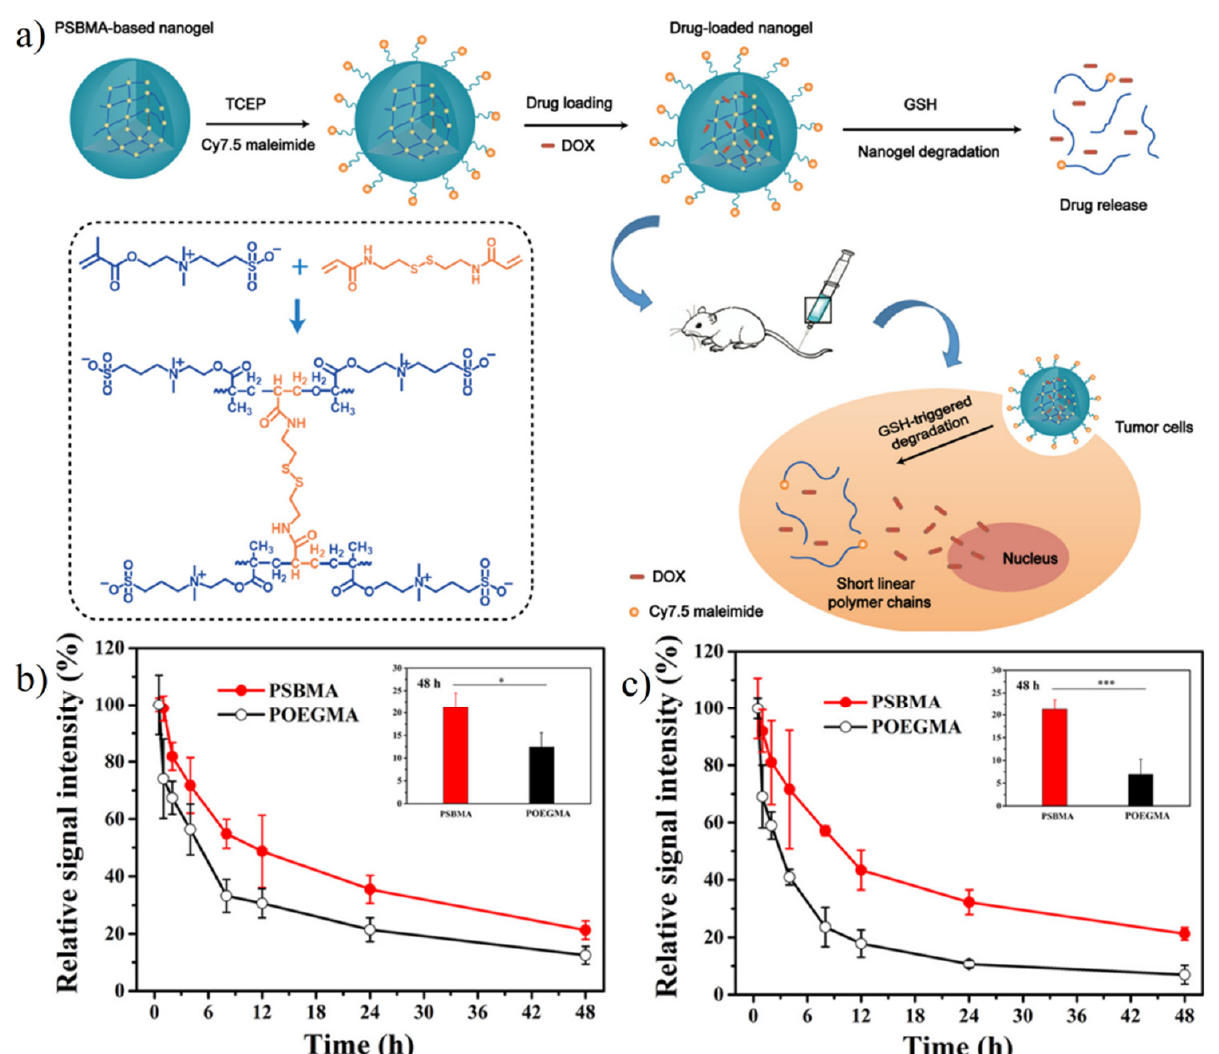
Figure 17. Redox-responsive controlled release of pSBMA-based nanogel. ( a ) Schematic illustration of doxorubicin-loaded biodegradable pSBMA-based nanogel for tumor therapy. ( b ) Blood retention of POEGMA nanogel and PSBMA nanogel after 1st injection. * < 0.05. ( c ) Blood retention of POEGMA nanogel and PSBMA after 2nd injection. *** < 0.00001. There was no significant difference of pharmacokinetics between 1st and 2nd injection shown in the PSBMA nanogel group. Reproduced with permission from [149]. Copyright 2018, American Chemical